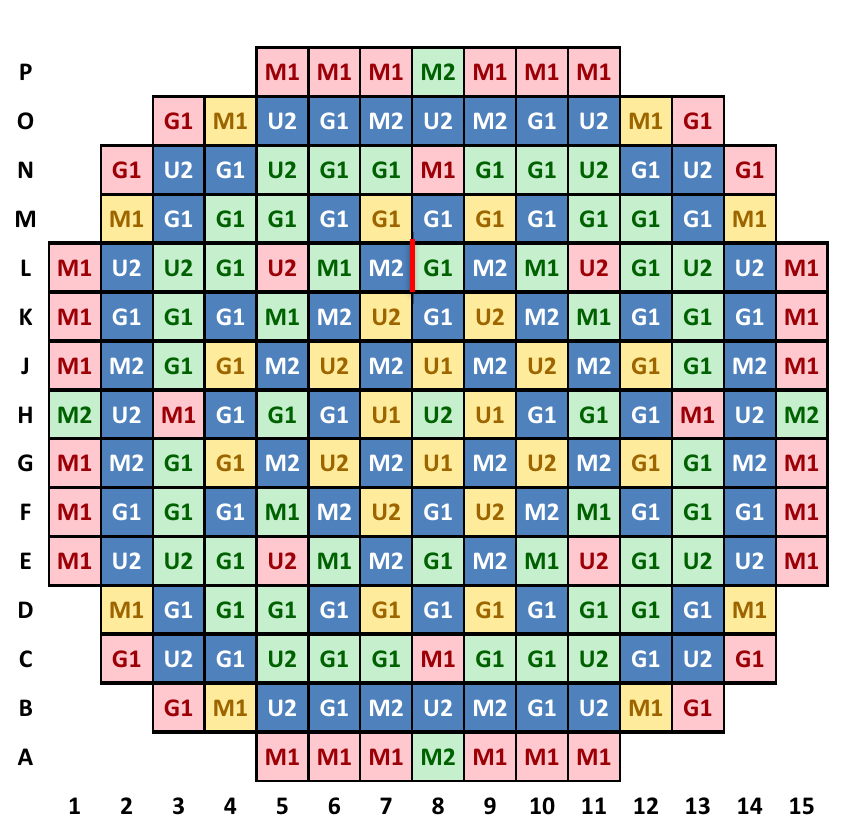
Figure 3. Core loading. The increased water gap between L7 and L8 is marked in